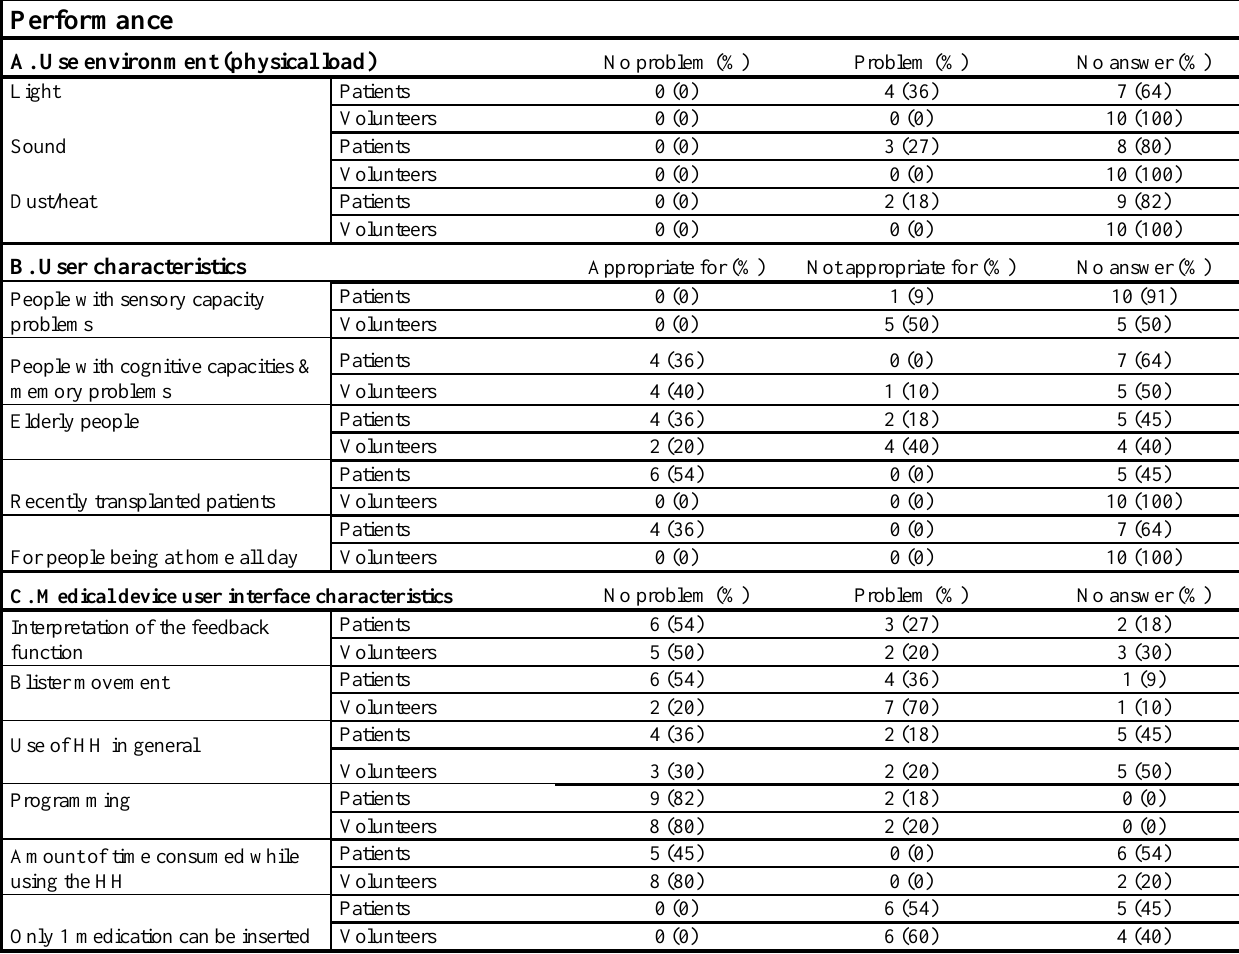
Table 3. Results on performance of the Helping Hand™ (patients: n = 11, volunteers: n = 10).